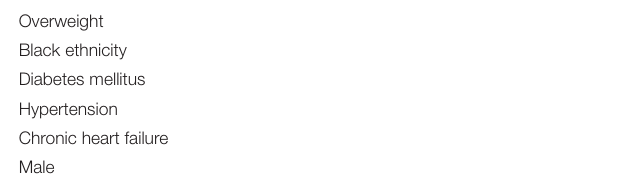
TABLE 1 | Risk factors for severe SARS-CoV-2